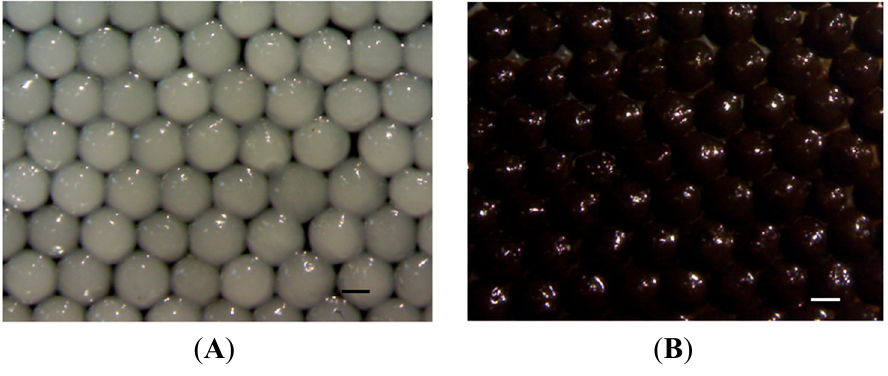
Figure 3. The photo images of immobilized CRL alginate composite beads ( A ) without MIO NPs and ( B ) with MIO